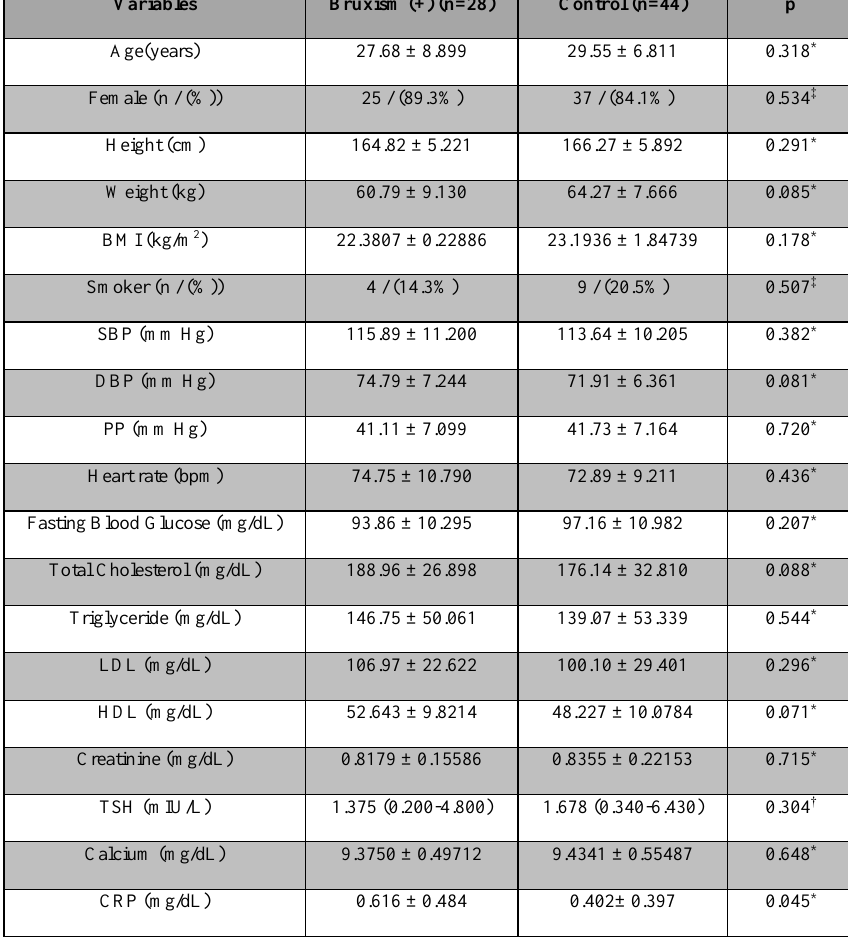
Table 1. Comparison of the general characteristics of Bruxism (+) and control subjects.